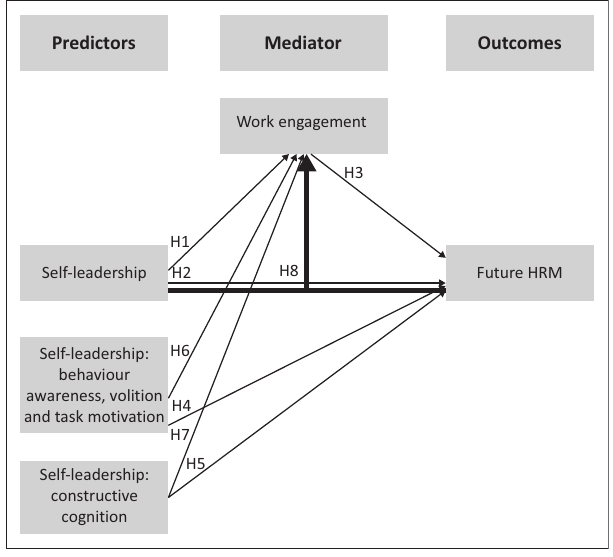
H5Self-leadership Self-leadership: FIGURE 1 : Hypothesised model.